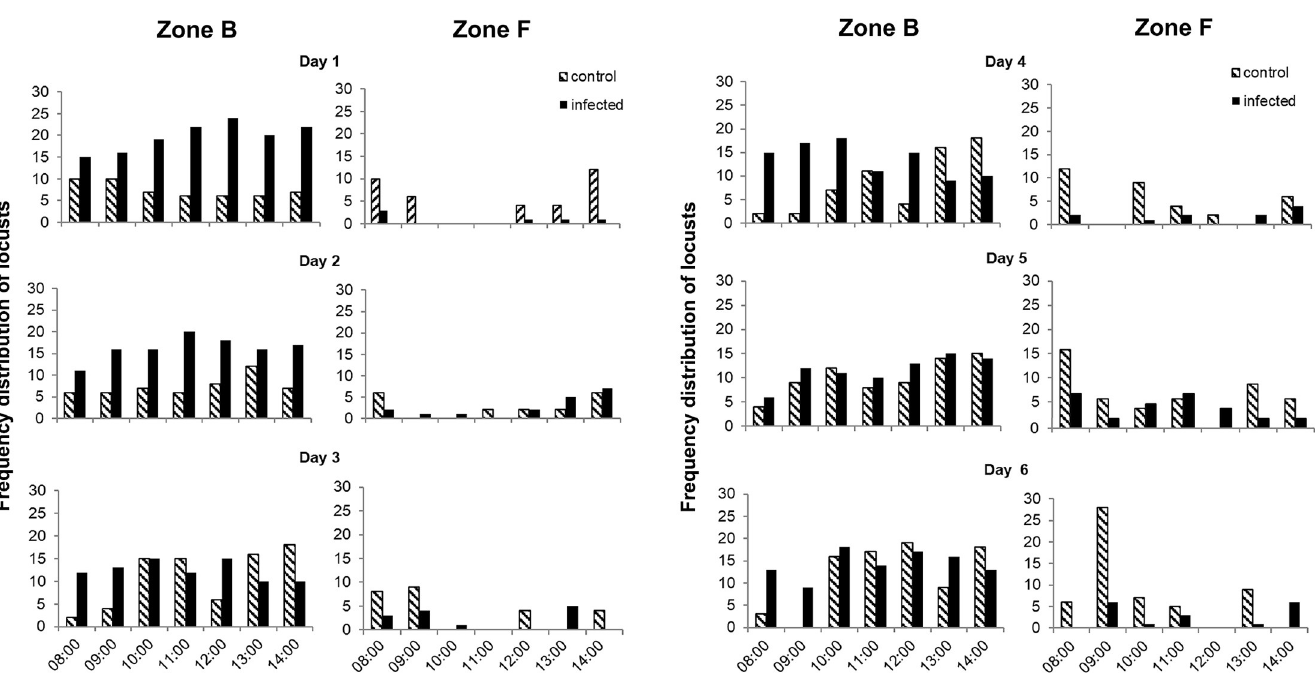
Fig 2. Feeding and basking behavior of infected Locusta migratoria manilensis . Frequency distribution of L . migratoria manilensis in zone B (basking) and zone F (feeding) in cages providing a heat gradient. Infected locusts were inoculated with Beauveria bassiana (10 4 spores/ 5 th instar nymph). n = 30 in three biological